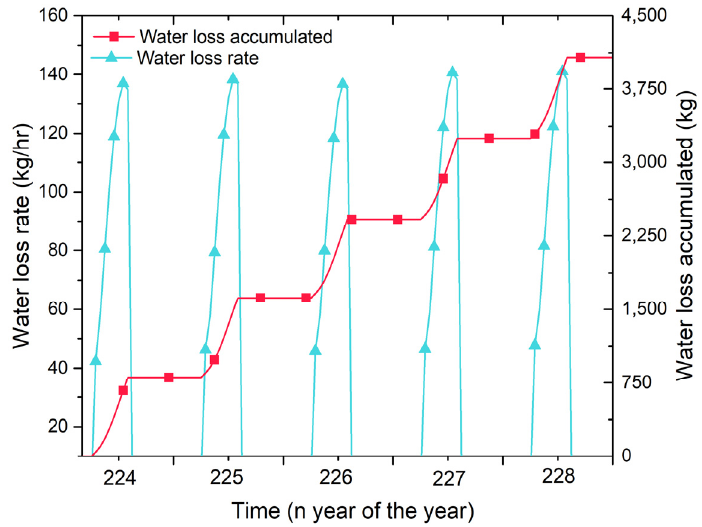
Figure 8. Rate of water loss due to evaporation in the cooling tower and its weekly accumulation.